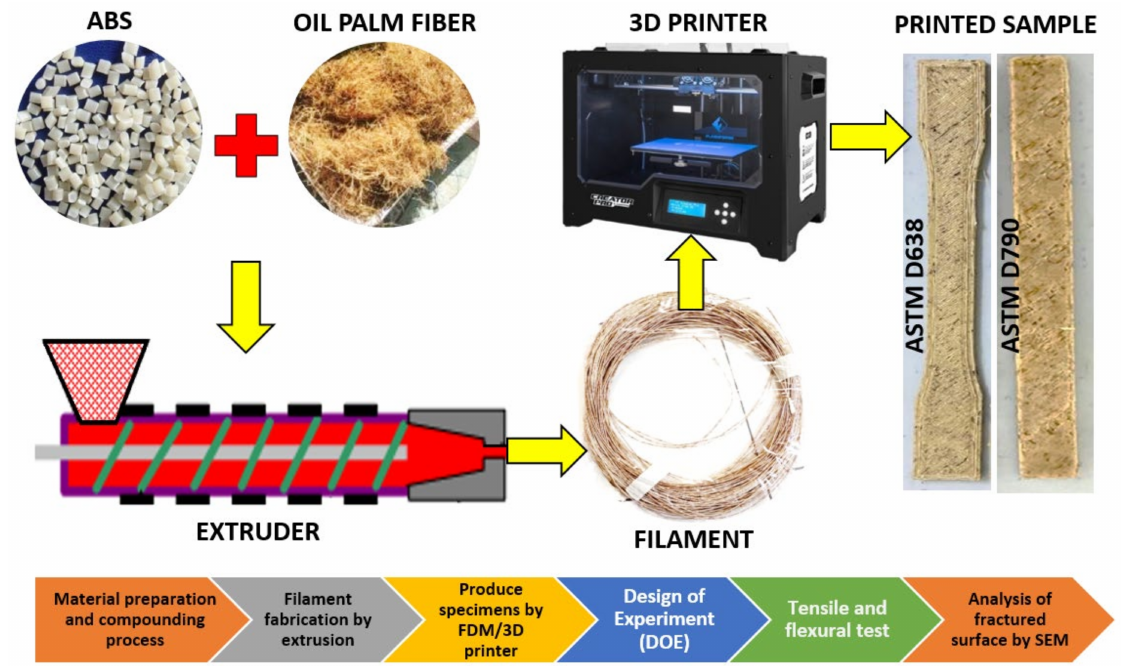
Figure 2. Process flow for fabrication and optimization of oil palm fiber reinforced thermoplastic